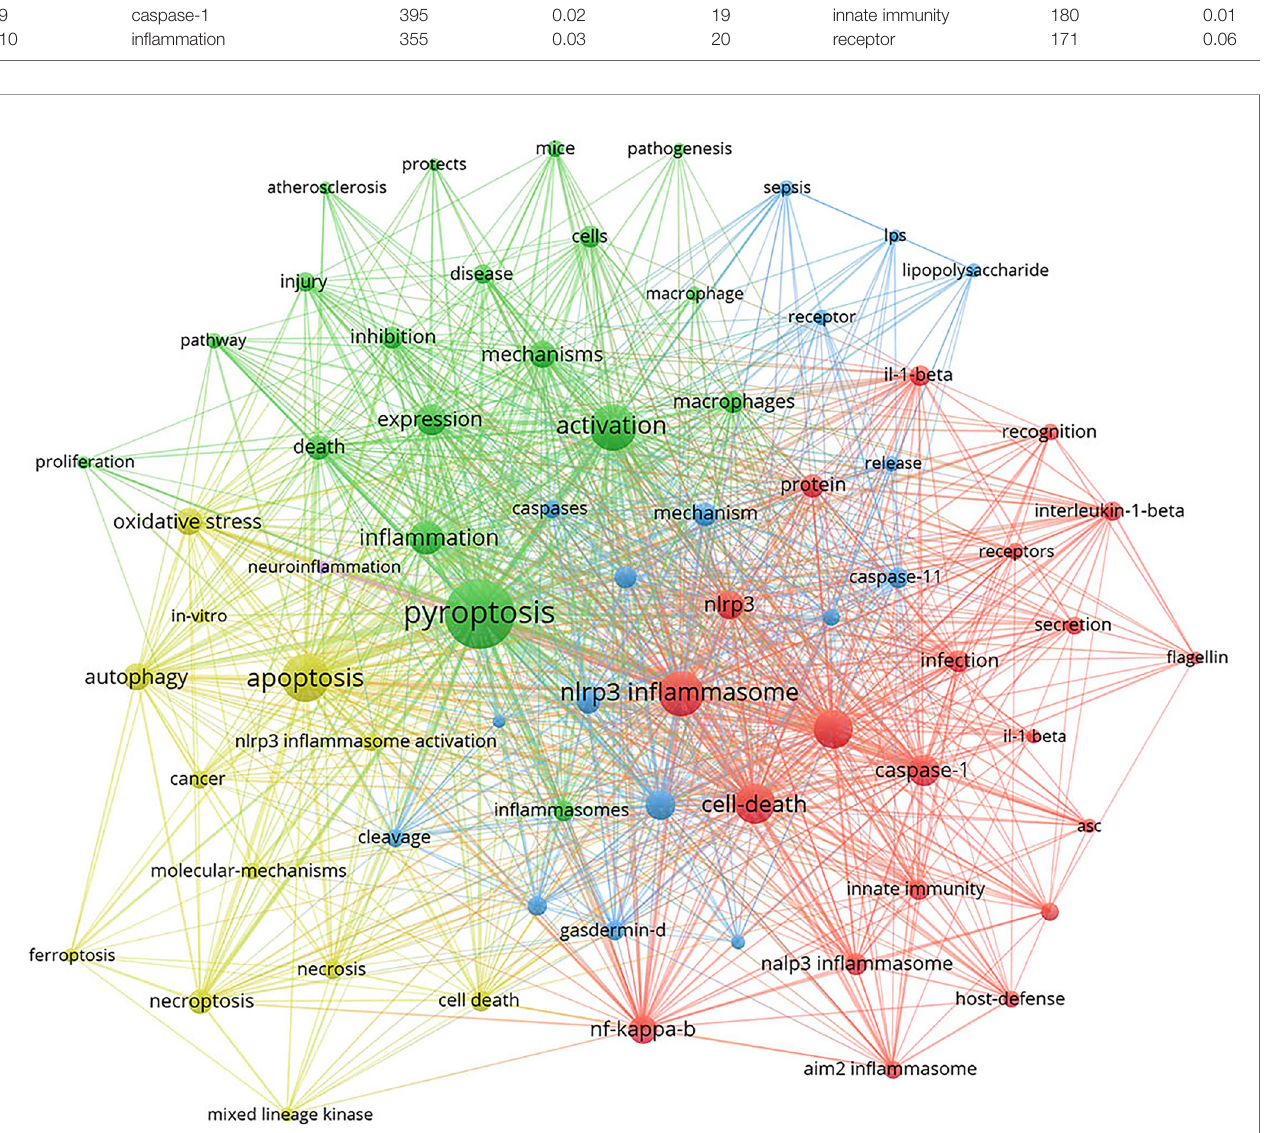
FIGURE 8 | CiteSpace visualization map of keywords clustering analysis related to